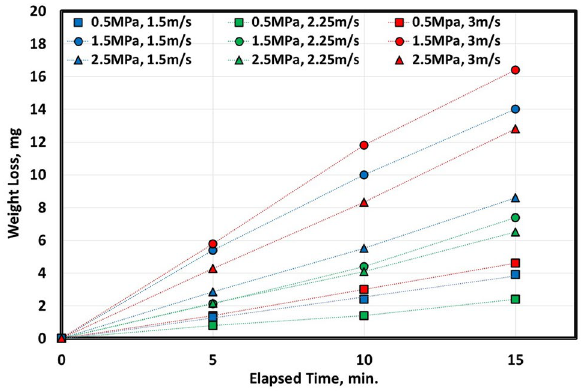
Figure 2. Variation of weight loss with different sliding speeds of 0.16C QAM f steel.